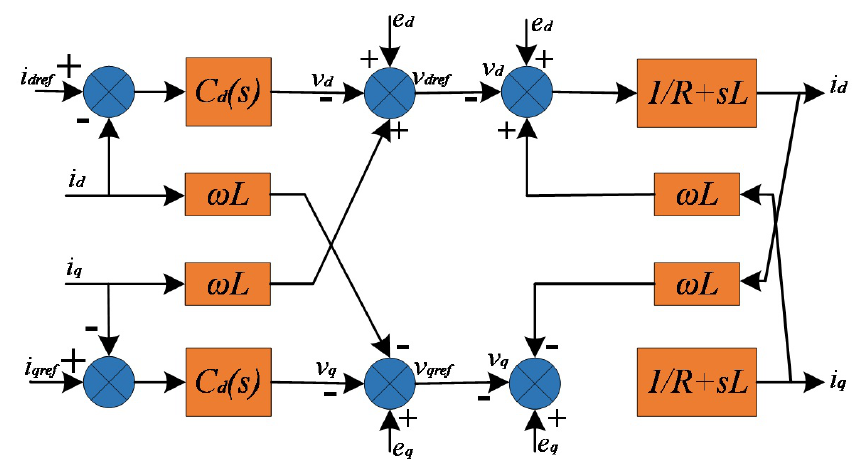
Figure 7. Decoupling control in the synchronous d − q rotating